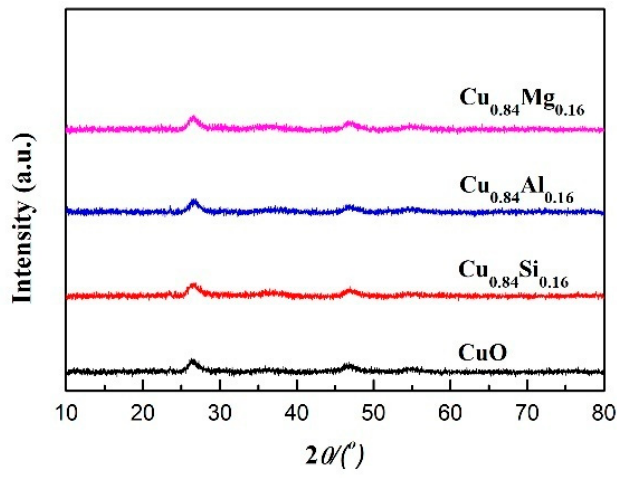
Figure 8. XRD patterns of used catalysts.